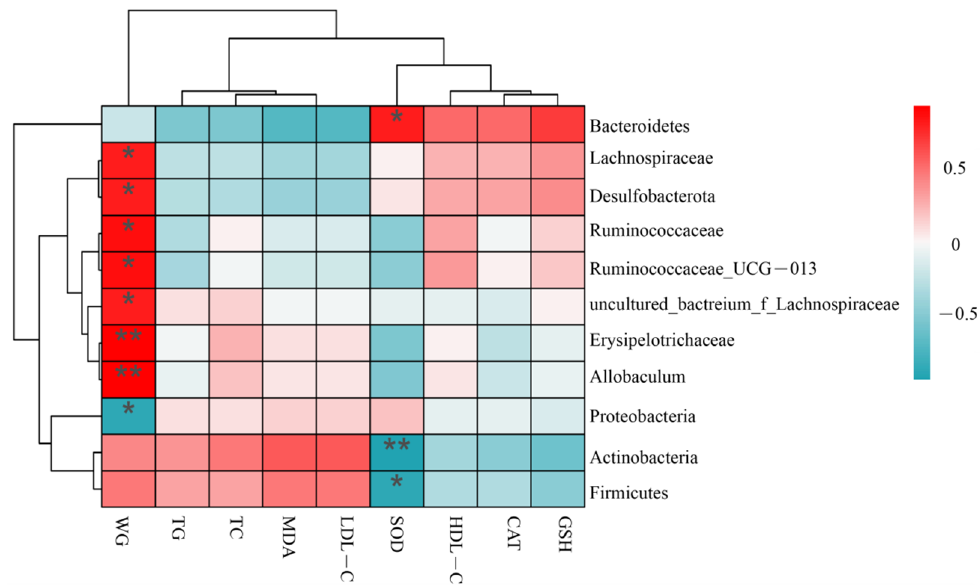
Figure 9. Spearman correlations between obesity-related parameters and microbiota. A blue designates a negative correlation, while a red shows a positive correlation. * ( p < 0.05), ** ( p < 0.01). WG in the graph represents weight body gain. WG: weight gain in mice; TC: total cholesterol; TG: triacylglycerol, HDL-C: high-density lipoprotein cholesterol, LDL-C: low-density lipoprotein cholesterol; SOD: total superoxide dismutase; MDA: malondialdehyde; GSH: Glutathione, CAT: catalase.